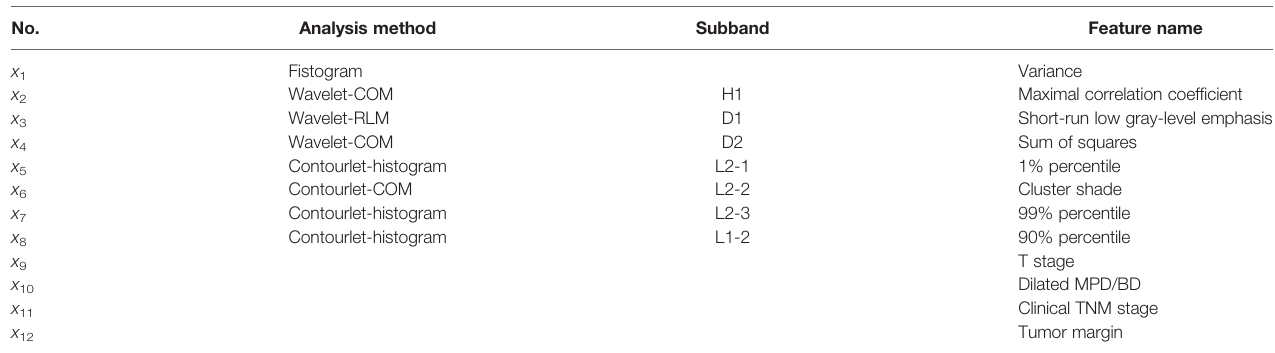
TABLE 2 | Radiomic signature and clinical